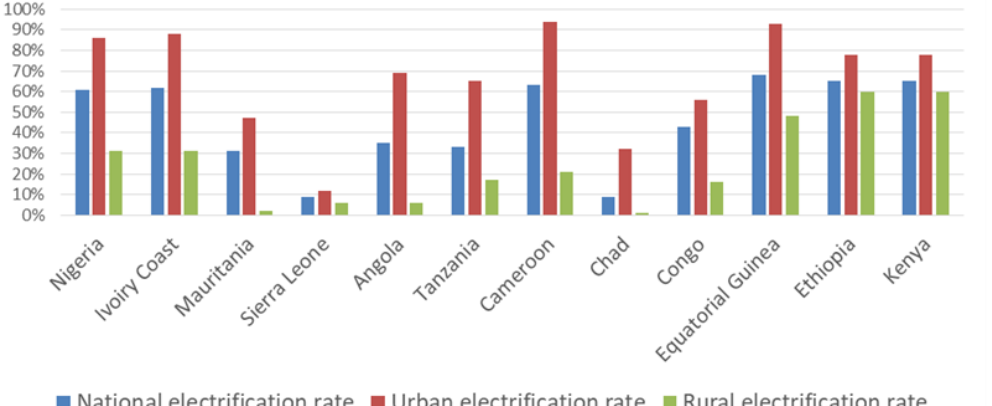
Figure 1. Electrification rates of some Sub-Saharan African (SSA) countries.